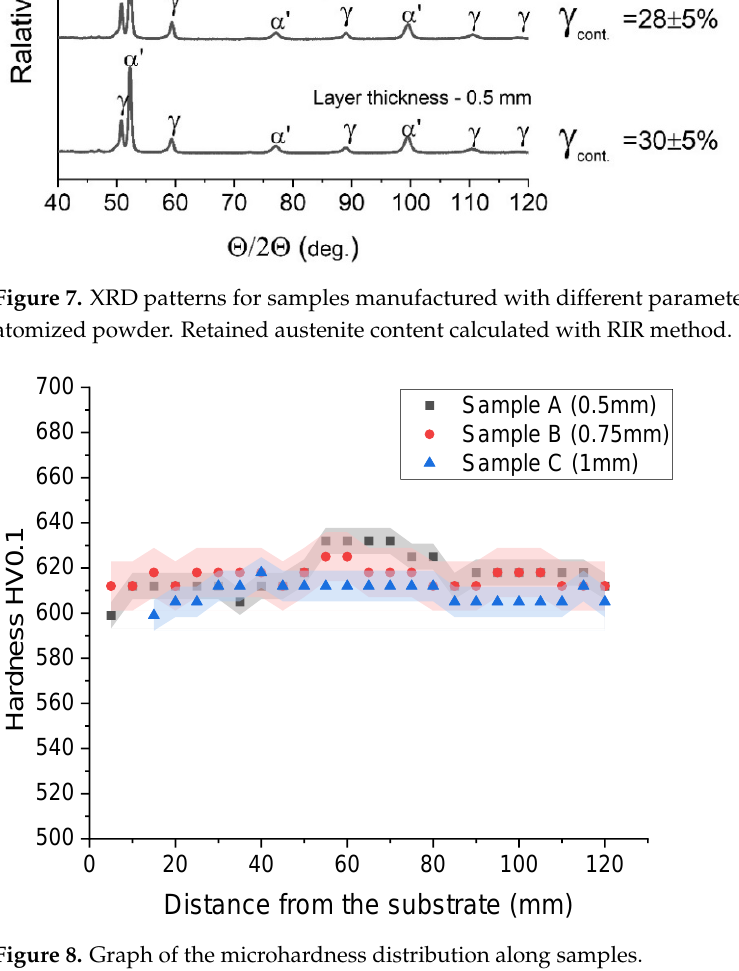
Figure 7. XRD patterns for samples manufactured with different parameters compared to the gas- atomized powder. Retained austenite content calculated with RIR method.